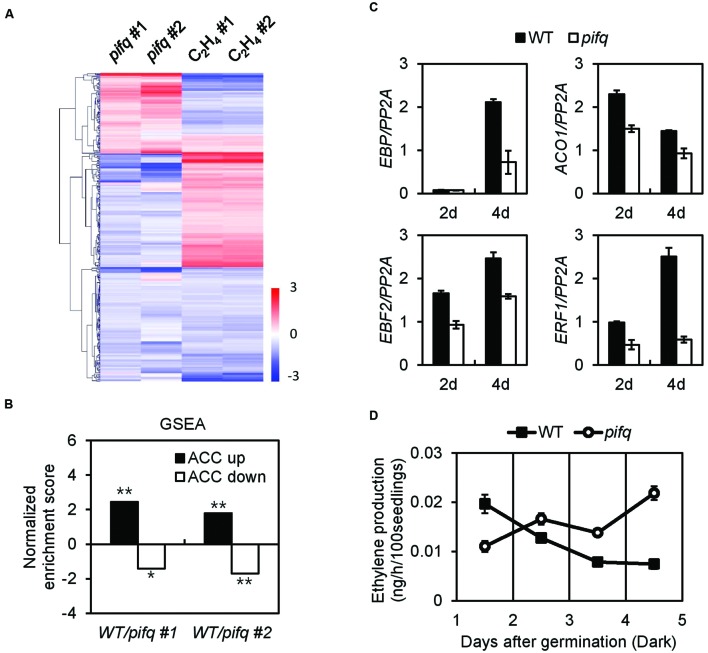
Ethylene responses are suppressed in pifq mutants regardless of endogenous ethylene levels. (A) Hierarchical clustering of two independent pifq microarrays and two independent ethylene treatment microarrays from dark-grown seedlings. 378 genes with P < 0.05 from the four microarrays were selected and analyzed. (B) Gene set enrichment analysis (GSEA) of the two independent pifq microarrays shows PIFs significantly up-regulate an ACC-inducible gene set and significantly down-regulate an ACC-repressible gene set (∗FDR = 0.086, ∗∗FDR < 0.005). (C) Expression of four representative ethylene marker genes from 2- and 4-day-old WT and pifq mutant etiolated seedlings. PP2A was used as an internal qPCR control. SD, n = 3 biological replicates. (D) Quantification of endogenous ethylene from WT and pifq mutants (SD, n = 3 biological replicates; ∗P < 0.05, Student’s t-test).